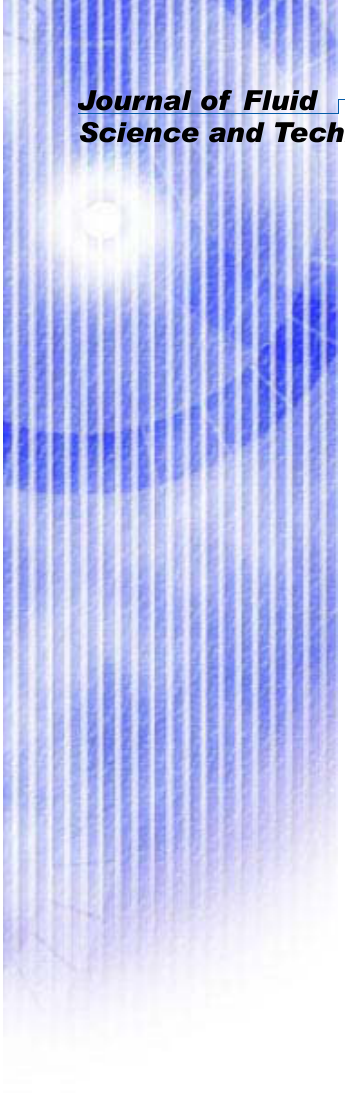
Fig. 8 Comparison of turbulent energy production in the initial stage of response (cid:4666)(cid:1876)/(cid:1830) (cid:3404) 0.1~4(cid:4667) (same symbols as Fig.